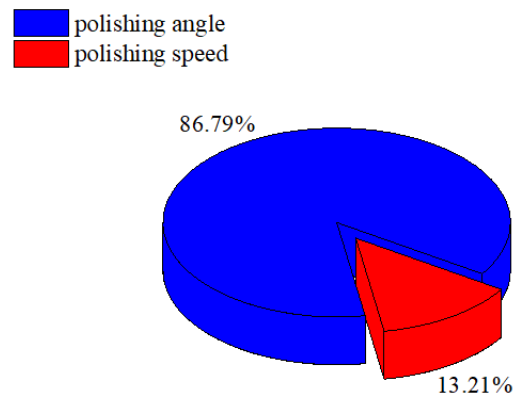
Figure 19. ANOVA results of R . The cutting edge prepared under the optimal conditions (polishing angle 10 ◦ , polishing speed 70 r · min − 1 ) was observed and compared with the original cutting edge. As shown in Figure 20, the original cutting edge has a large number of serrated micro-notches, and there are many scratches of different depths on the surface. After the cutting edge is prepared, the burrs and scratches are completely removed, and the cutting edge is